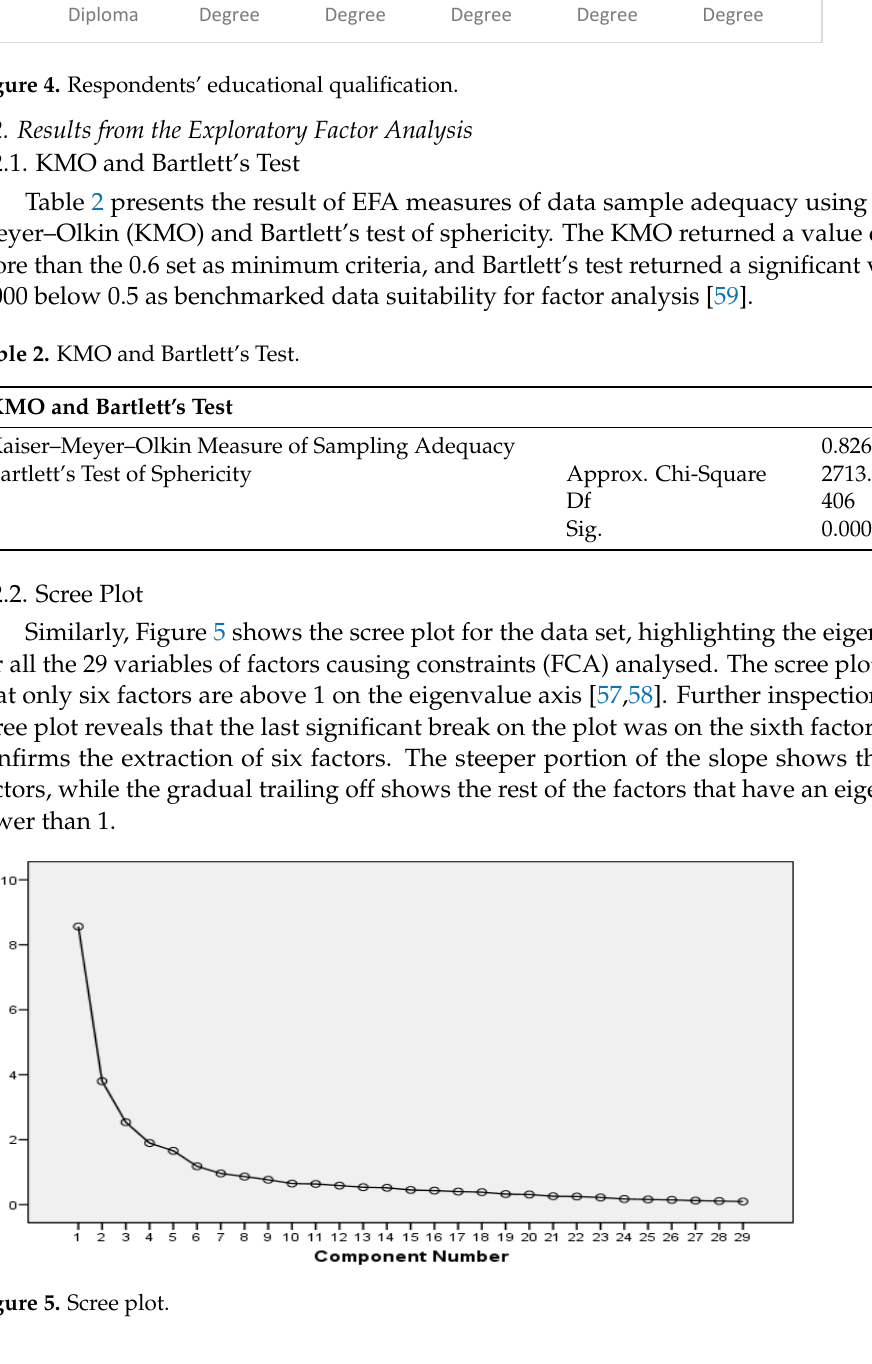
Figure 4. Respondents’ educational qualification.